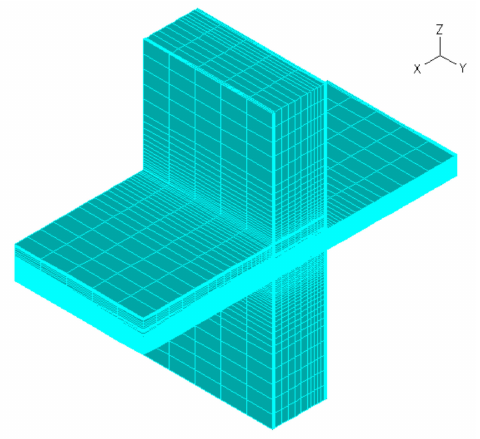
Figure 3. The geometry of the numerical model after creation of a finite element